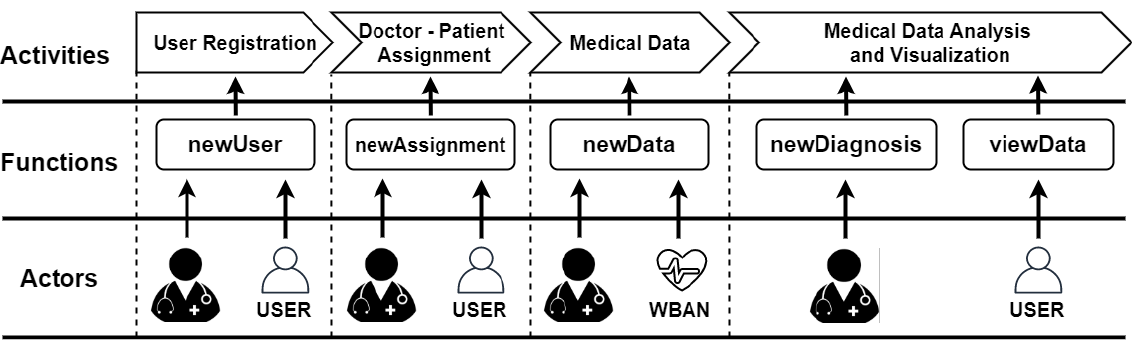
Figure 5. Smart-contract